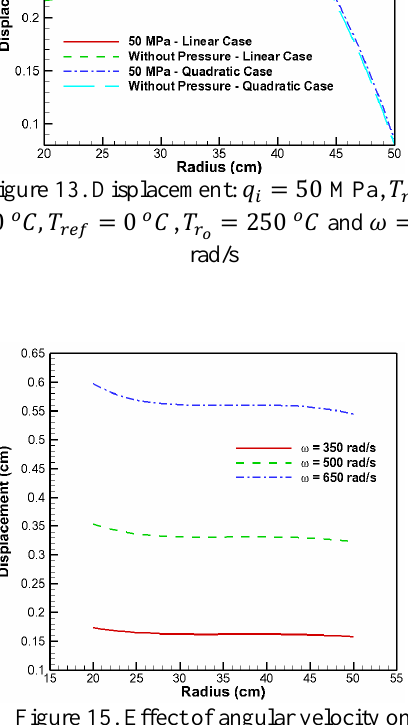
= 50 MPa, 𝑇 𝑖 = 250 𝑜 𝐶 and 𝜔 = 350 𝑟 𝑜 rad/s